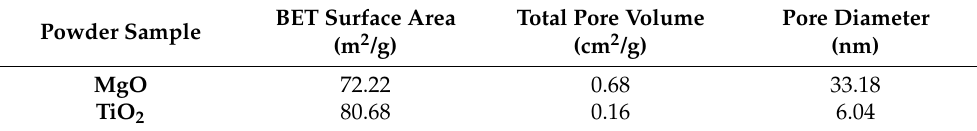
Figure 2. SEM images of powders: ( a ) MgO and ( b ) TiO2. The BET surface area analysis results are presented in Table 1. Although the samples have comparable surface area, MgO nano-powders are significantly more porous. Table 1. TiO 2 and MgO powders surface properties determined from BET measurements. BET Surface Area Powder Sample